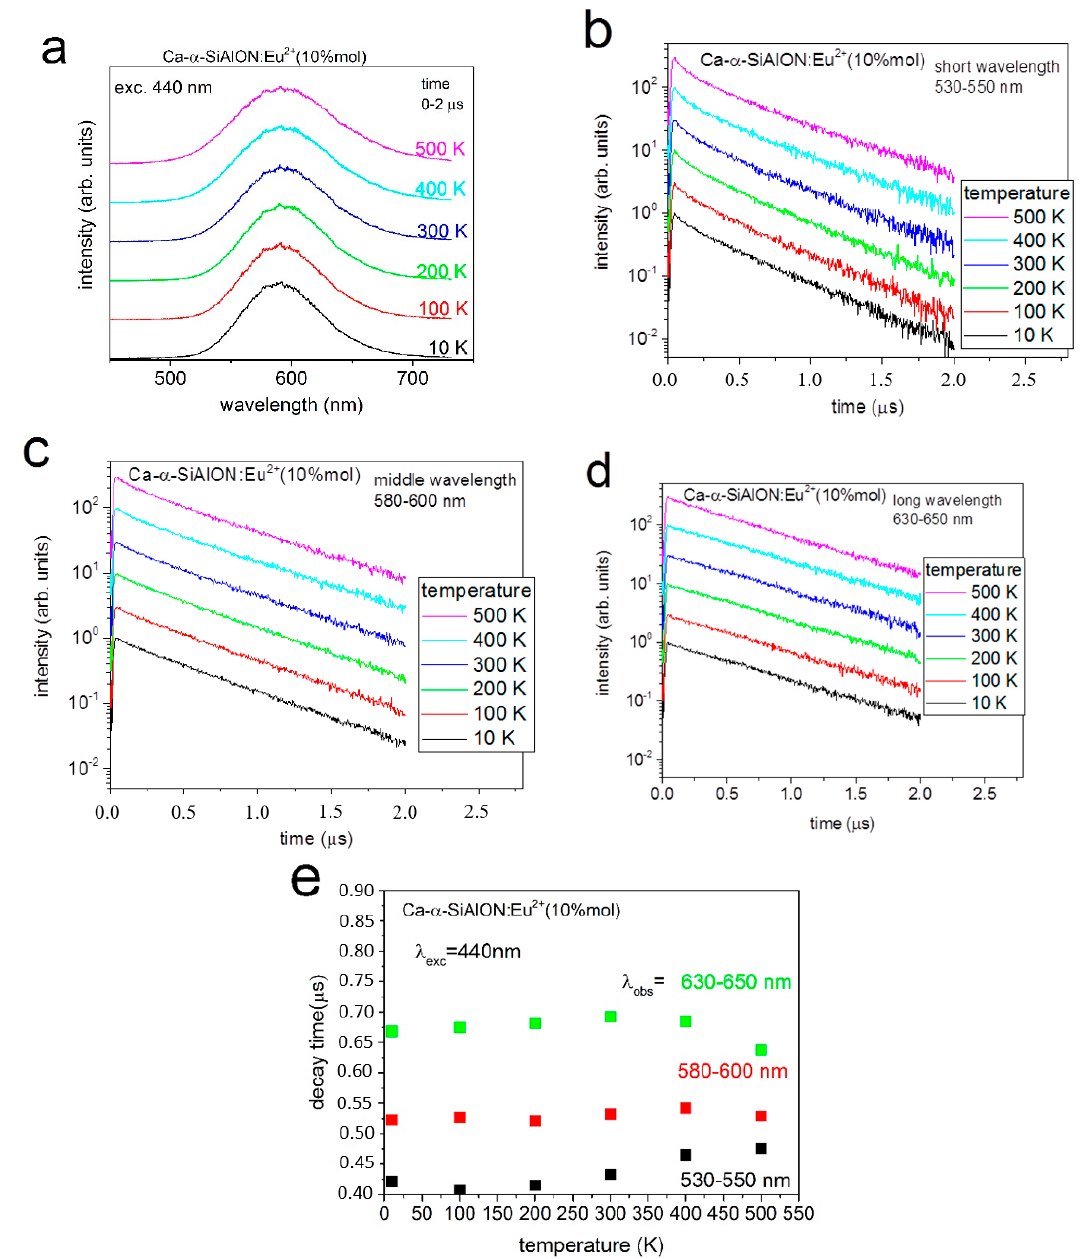
Figure 9. ( a ) Time resolved luminescence spectra of Ca 0.8 Si 9.6 Al 2.4 O 0.8 N 15.2 :Eu 2+ (10 mol%) observed in the time range 0–2 µs, excited with 440 nm at various temperature. ( b – d ) Luminescence decay curves of Ca 0.8 Si 9.6 Al 2.4 O 0.8 N 15.2 :Eu 2+ (10 mol%) excited with 440 nm at different temperatures. Luminescence decays are monitored at three region of wavelength ( b ) 530–550 nm ( c ) 580–600 nm ( d ) 630–650 nm (marked with rectangles) ( e ) Decay times calculated by single exponential fit of decay profiles for the selected region of luminescence wavelength .